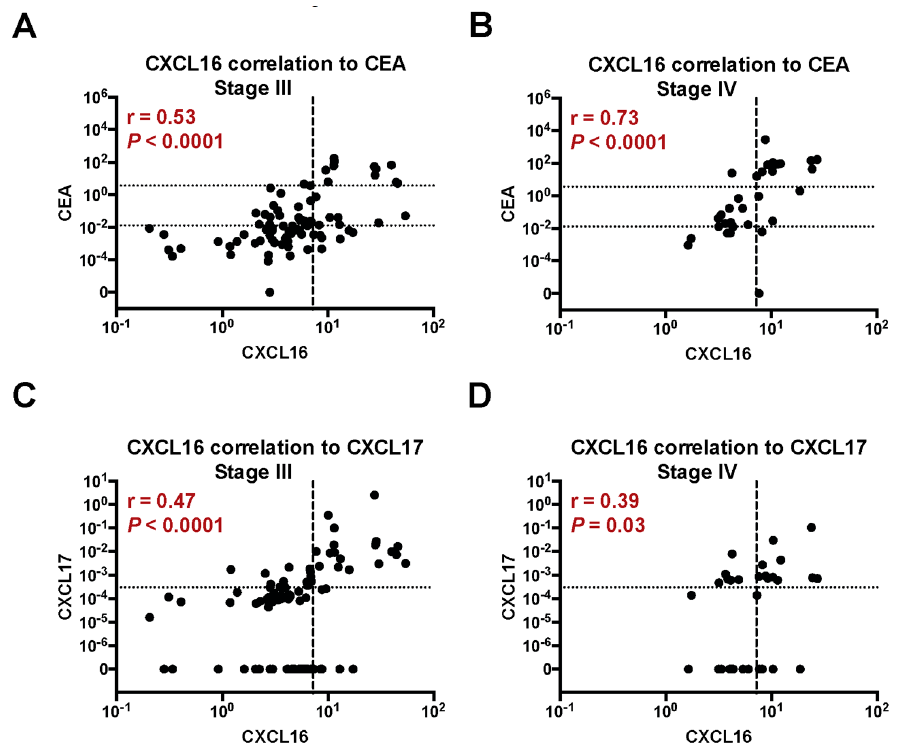
Figure 3. Correlations between mRNA levels of CXCL16 and mRNA levels of CEA and CXCL17 in lymph nodes of CC patients in TNM stages III and IV. ( A , B ) The correlations between CXCL16 mRNA levels and mRNA levels of CEA in patients in stages III and IV. ( C , D ) The correlations between CXCL16 mRNA levels and mRNA levels of CXCL17 in patients in stages III and IV. Dashed lines indicate a clinical cut-o ff value of 7.2 mRNA copies / 18S rRNA unit of CXCL16. Dotted lines in ( A , B ) indicate the borders between three groups of lymph nodes divided according to their CEA mRNA levels; CEA( − ) = CEA mRNA levels < 0.013 copies / 18S rRNA unit, CEA(int) = intermediate CEA mRNA levels, that is 0.013–3.67 copies / 18S rRNA unit, and CEA( + ) = CEA mRNA levels > 3.67 copies / 18S rRNA unit. Dotted lines in ( C , D ) indicate the border between CXCL17(–) and CXCL17( + ) lymph nodes, that is, a CXCL17 mRNA level of 0.0003 mRNA copies / 18S rRNA unit. The correlation coe ffi cients (r) and the P-values were calculated by two-tailed Spearman’s rank order correlation test. Levels are given as mRNA copies/18S rRNA unit.